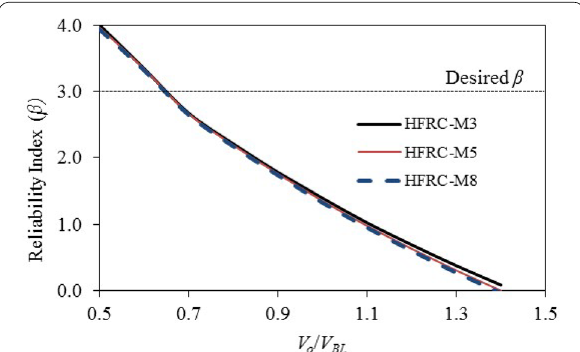
Fig. 5 Variation of reliability index of HFRC specimens with V 0 / V BL